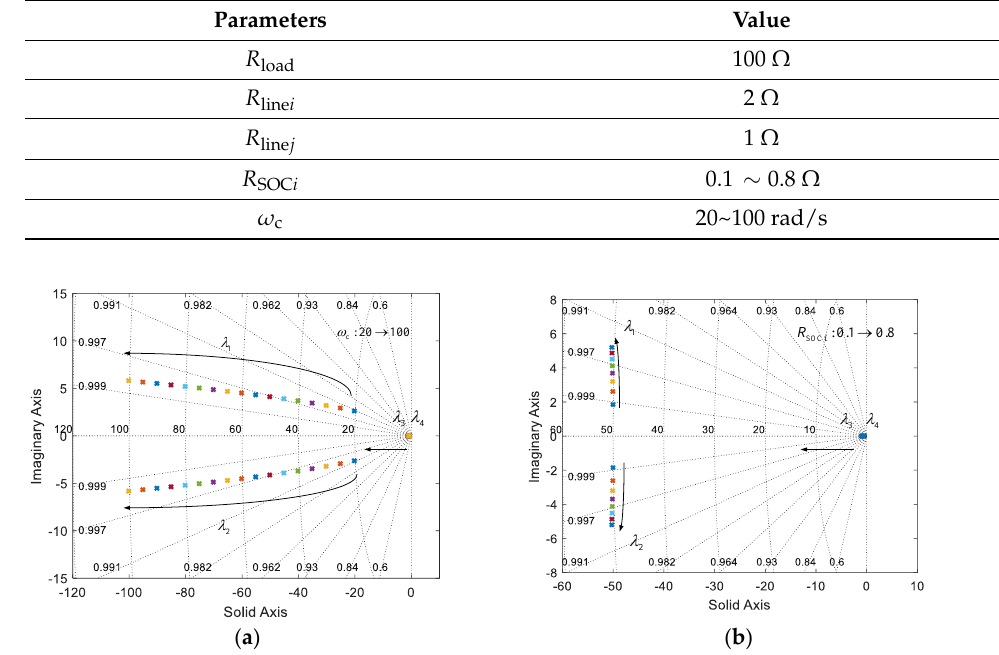
Figure 8. Root trajectory diagram: ( a ) cutoff frequency change; ( b ) change in sag factor.